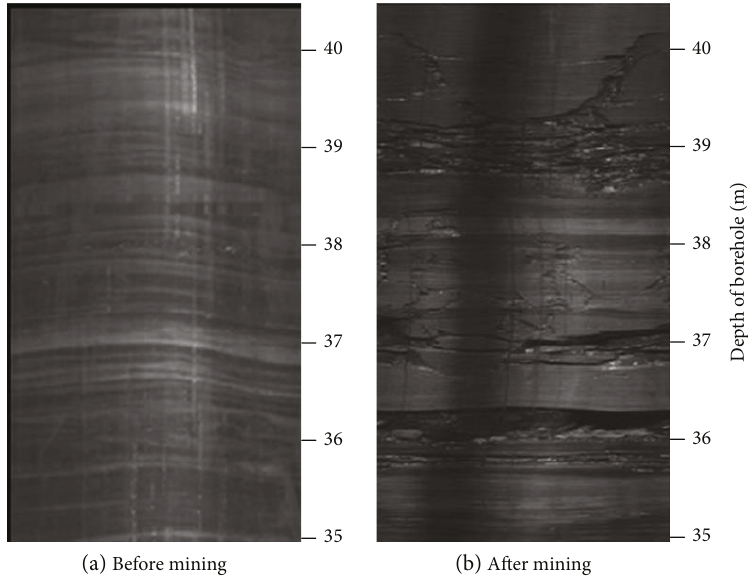
Figure 8: Fracture distribution of borehole before and after mining.